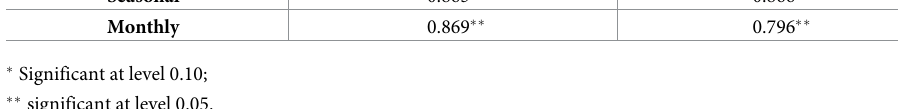
Desert, and in the Kubuqi Desert. The spatial distribution of the NDVI trends in summer was